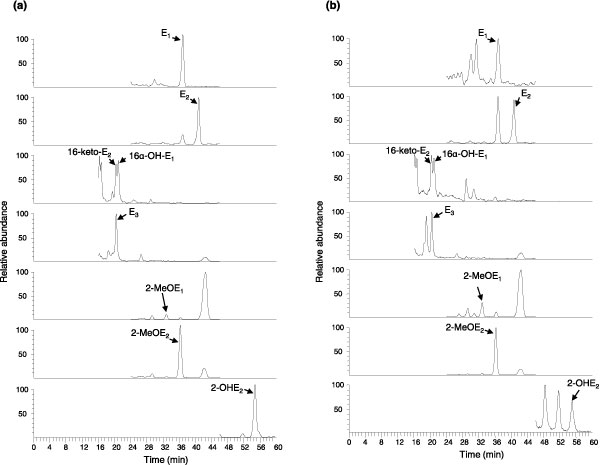
Chromatograms showing the eight quantified endogenous estrogen metabolites for (a) the ovarian cancer cell line SK-OV-3 and (b) the colon cancer cell line HCC-2998. 16-ketoE2, 16-ketoestradiol; 16α-OHE1, 16α-hydroxyestrone; 2-MeOE1, 2-methoxyestrone; 2-MeOE2, 2-methoxyestradiol; 2-OHE2, 2-hydroxyestradiol; E1, estrone; E2, estradiol; E3, estriol.